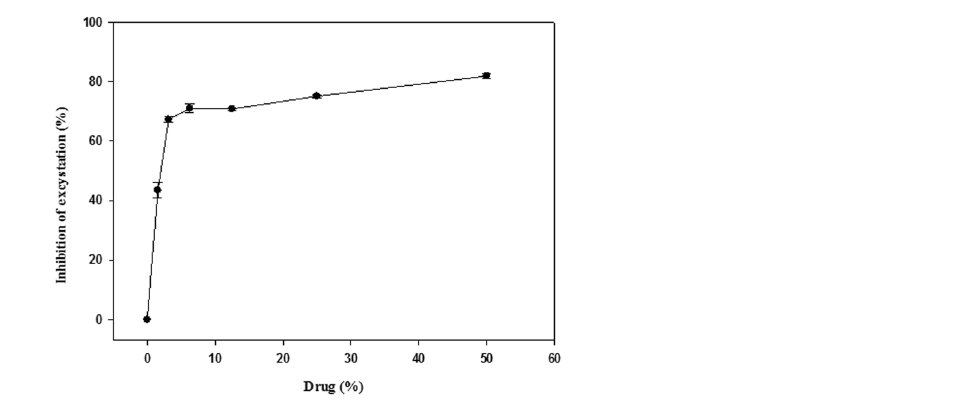
Figure 2. Effect of Eye drop solution ‘Systane Ultra’ on the excystation process of Acanthamoeba castellanii